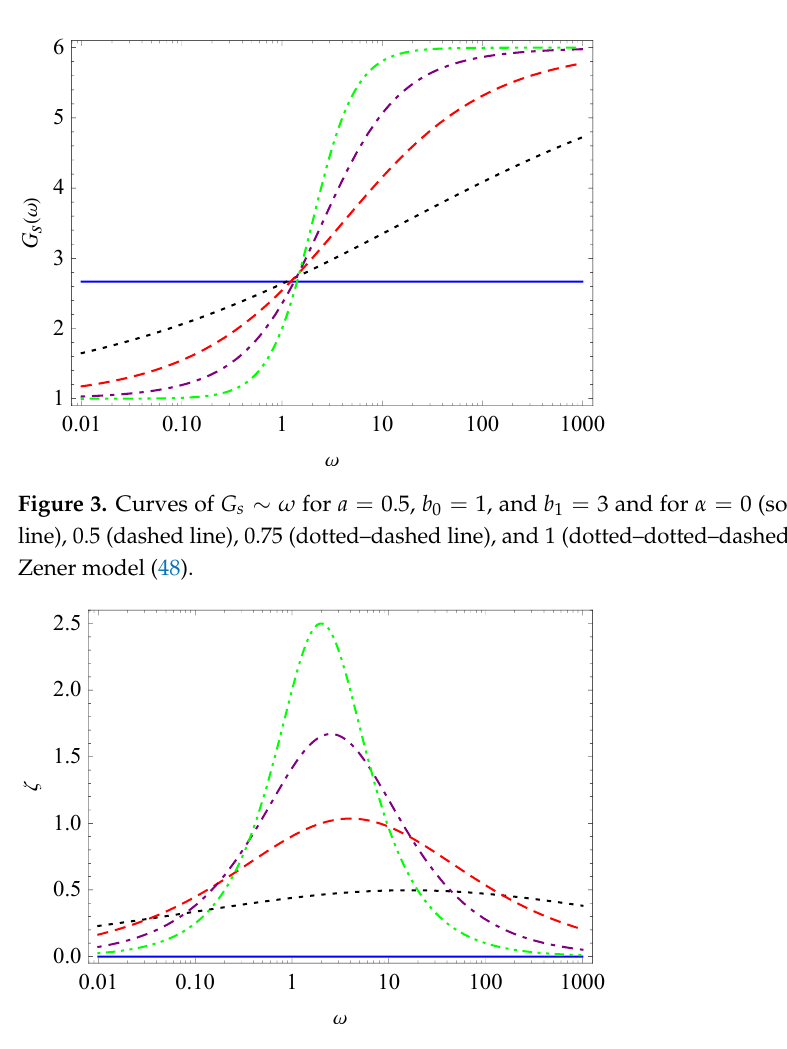
Figure 4. Curves of ζ ∼ ω for a = 0.5, b 0 = 1, and b 1 = 3 and for α = 0 (solid line), 0.25 (dotted line), 0.5 (dashed line), 0.75 (dotted–dash line), and 1 (dotted–dotted–dashed line) in the fractional Zener model